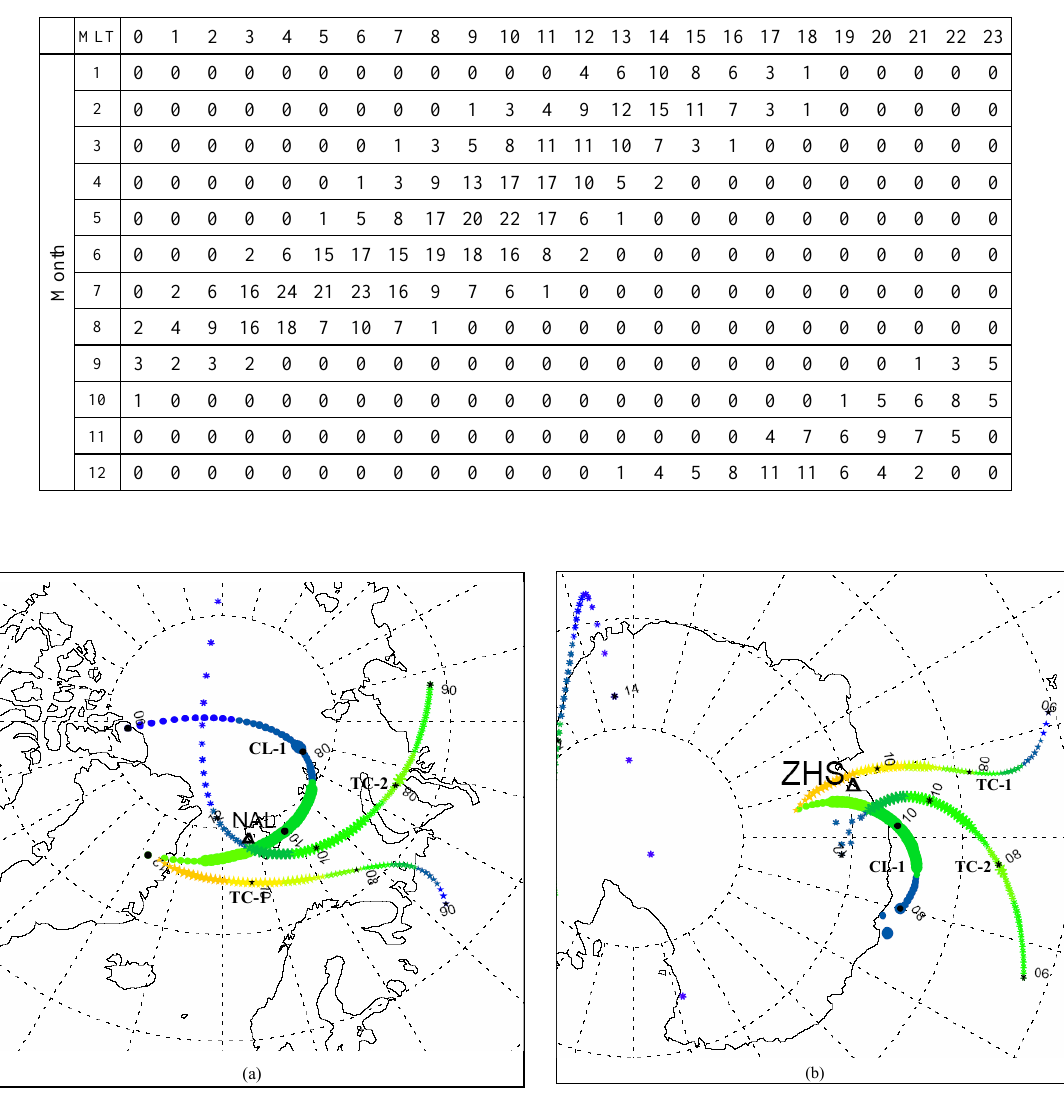
Fig. 8 Locations of the footprints of TC-1, TC-2 and CL-1 spacecraft in (a) the northern hemisphere and (b) the southern hemisphere, respectively, during 06:00-18:00UT on 25 Feb. 2005.